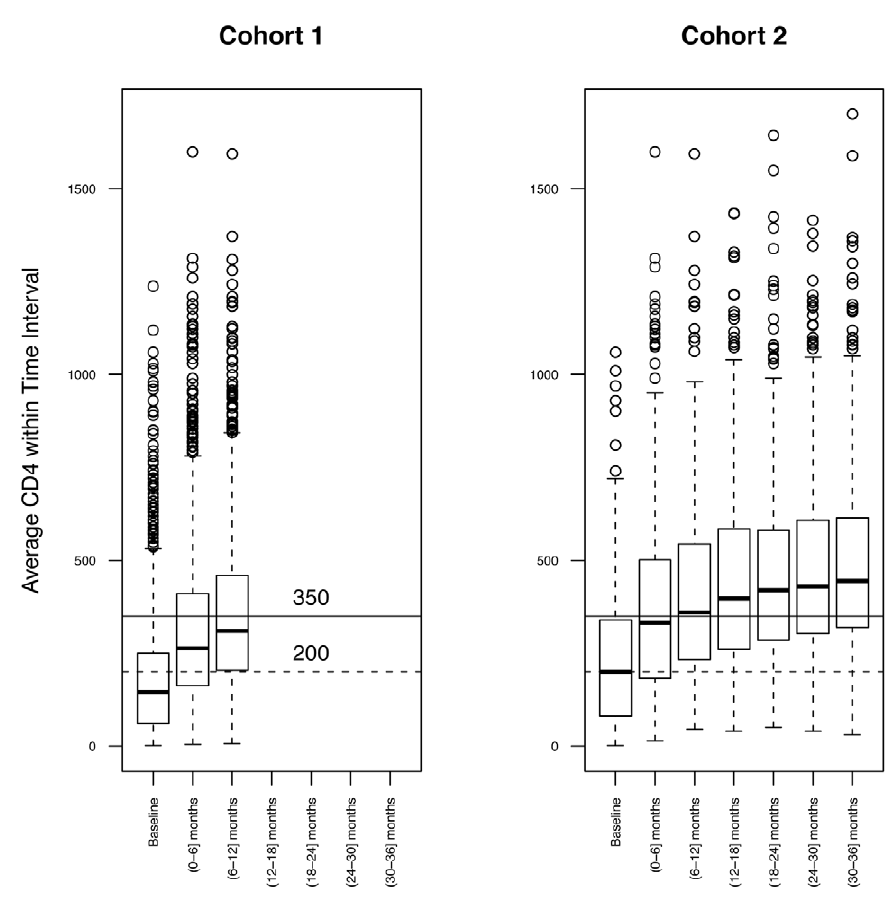
Figure 1. Distribution of CD4 count. The distribution of CD4 count at 6-mo time intervals was assessed for both Cohort 1 (left) and Cohort 2 (right). Means were calculated for patients with multiple CD4 count assessments in the same interval.